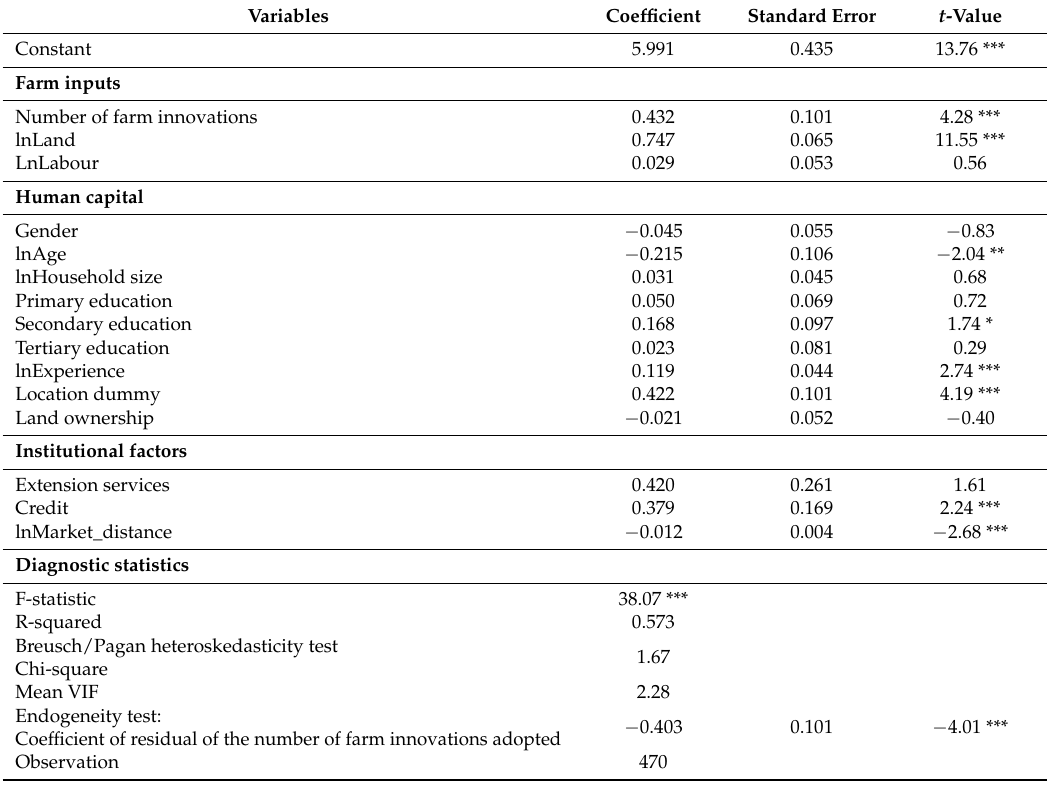
Table 4. Determinants of rice